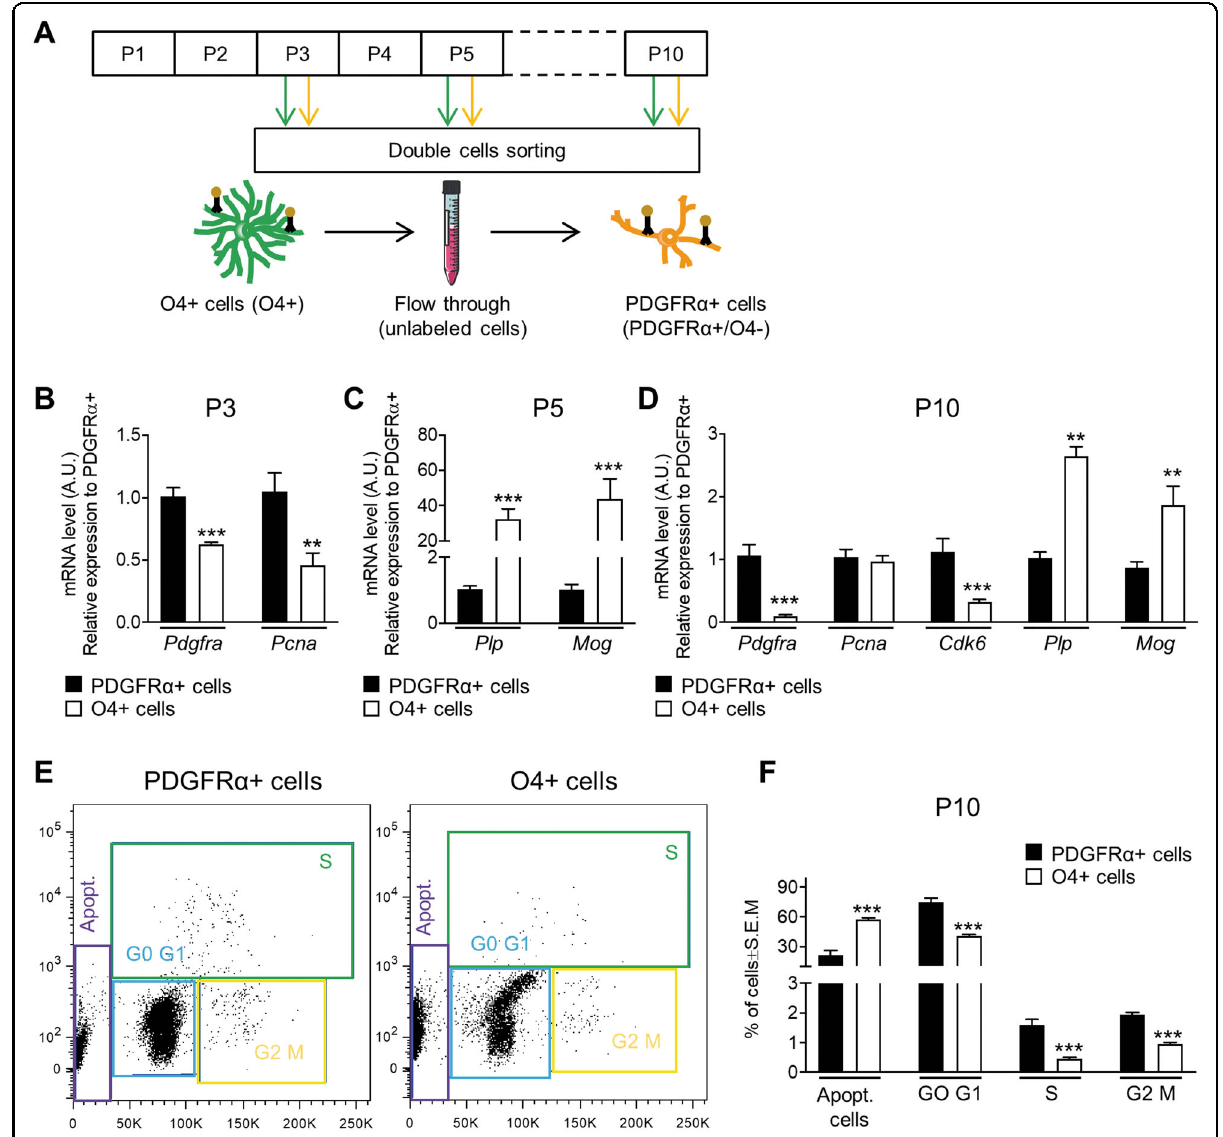
Fig. 1 PDGFR α + and O4 + sorted cells have a different proliferative and differentiative potential. A Schematic representation of the sequential isolation of O4 + and PDGFR α + cells by magnetic bead separation (MACS) from control male mice at P3, P5, and P10. B – D qPCR analysis of different markers of cell proliferation ( Pcna and Cdk6 ) and differentiation ( Pdgfr α , Mog, Plp ) in PDGFR α + and O4 + sorted cells at B P3, C P5, and D P10 (data are mean ± SEM, n = 6 groups/condition at P3 and P10 and n = 18 groups/condition from three independent experiments at P5, ** P < 0.01 or *** P < 0.001 Unpaired t -Test). E , F Flow cytometry plots and analyses of the percentages of cells at the different phase of the cell cycle (data are mean ± SEM, n = 6 groups/condition, *** p < 0.001, Unpaired t